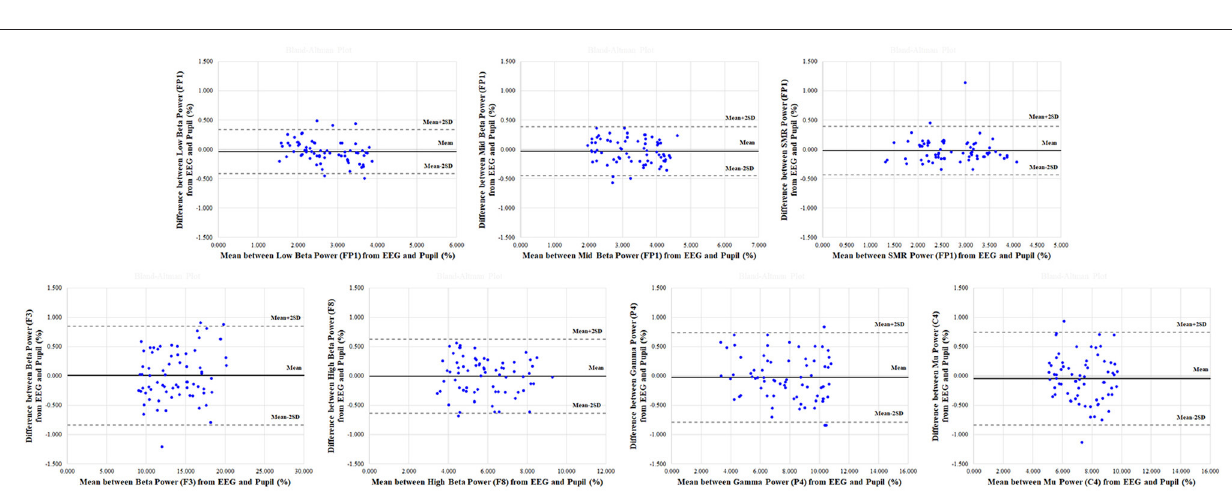
FIGURE 8 | Representative Bland-Altman plots in physiological variation condition for electroencephalogram (EEG) spectral indexes (low beta in FP1; mid beta in FP1 region; SMR in FP1; beta in F3; high beta in F8; gamma in P4; mu in C4) between pupil and EEG signals. The center solid line represents the mean difference between two measures, with the upper and lower dotted lines representing the 95% limits ( ± 2 SD) of agreement ( n =